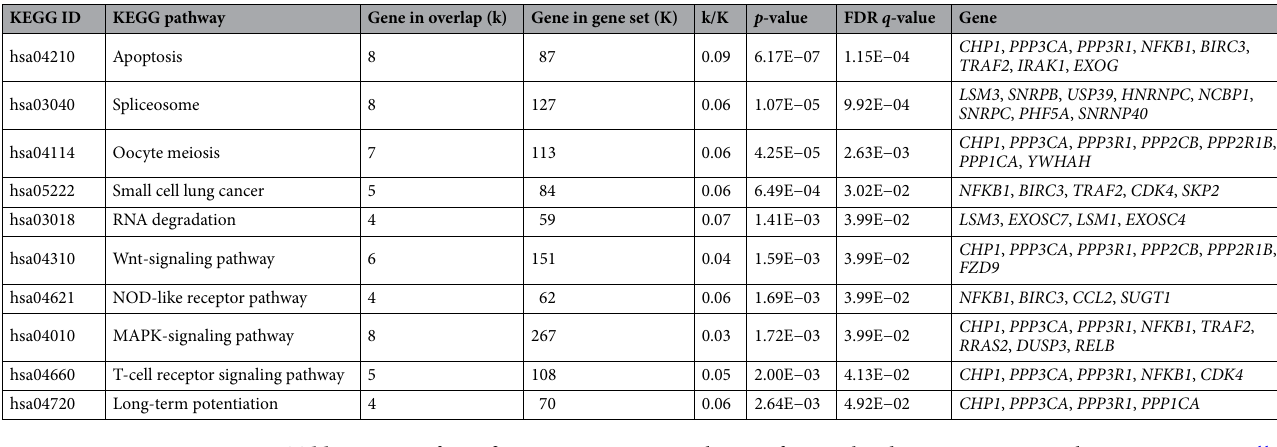
Table 2. Lists of significant unique KEGG pathways of upregulated GO terms in 2BmCherry transcriptome 11 .